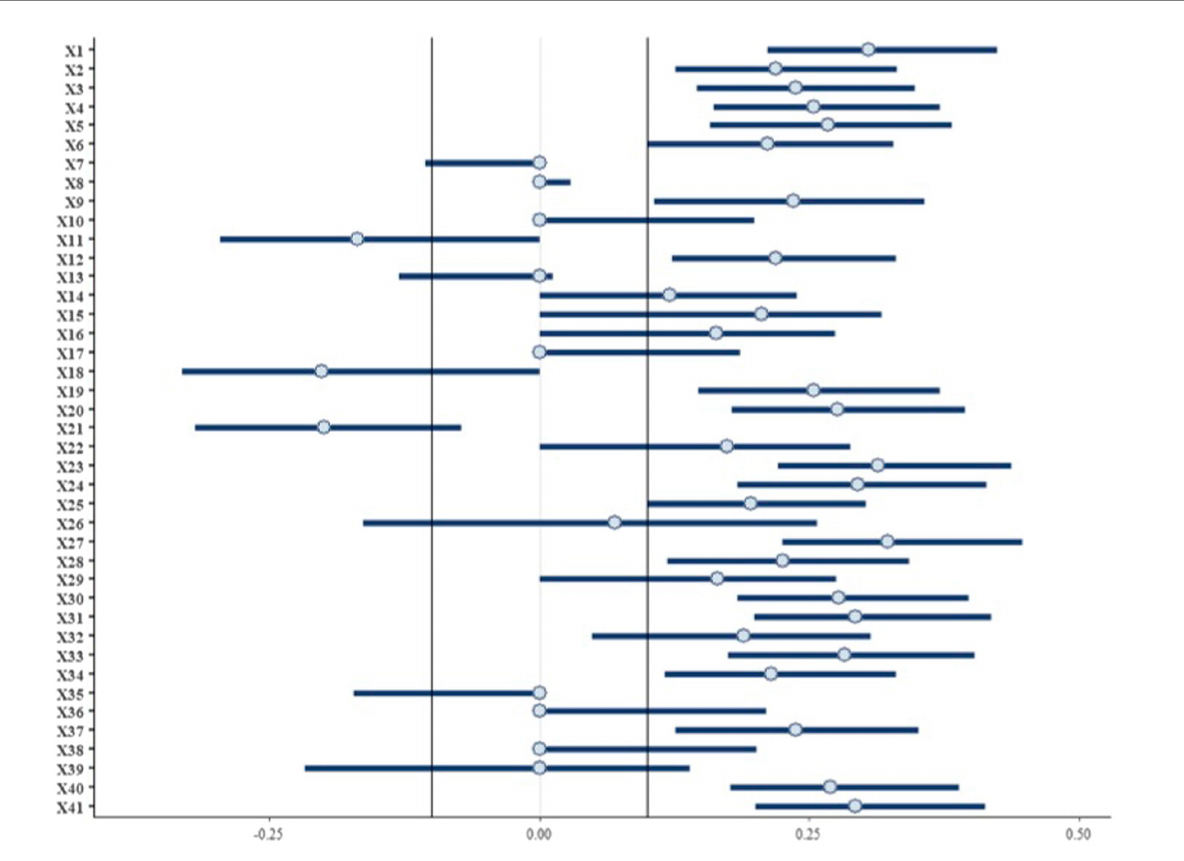
FIGURE 2 Bayesian Exploratory Factor Analysis 95% highest density interval (HDI) posterior estimate on the standardized factor loading. The region of practical equivalence area is identified through black lines.